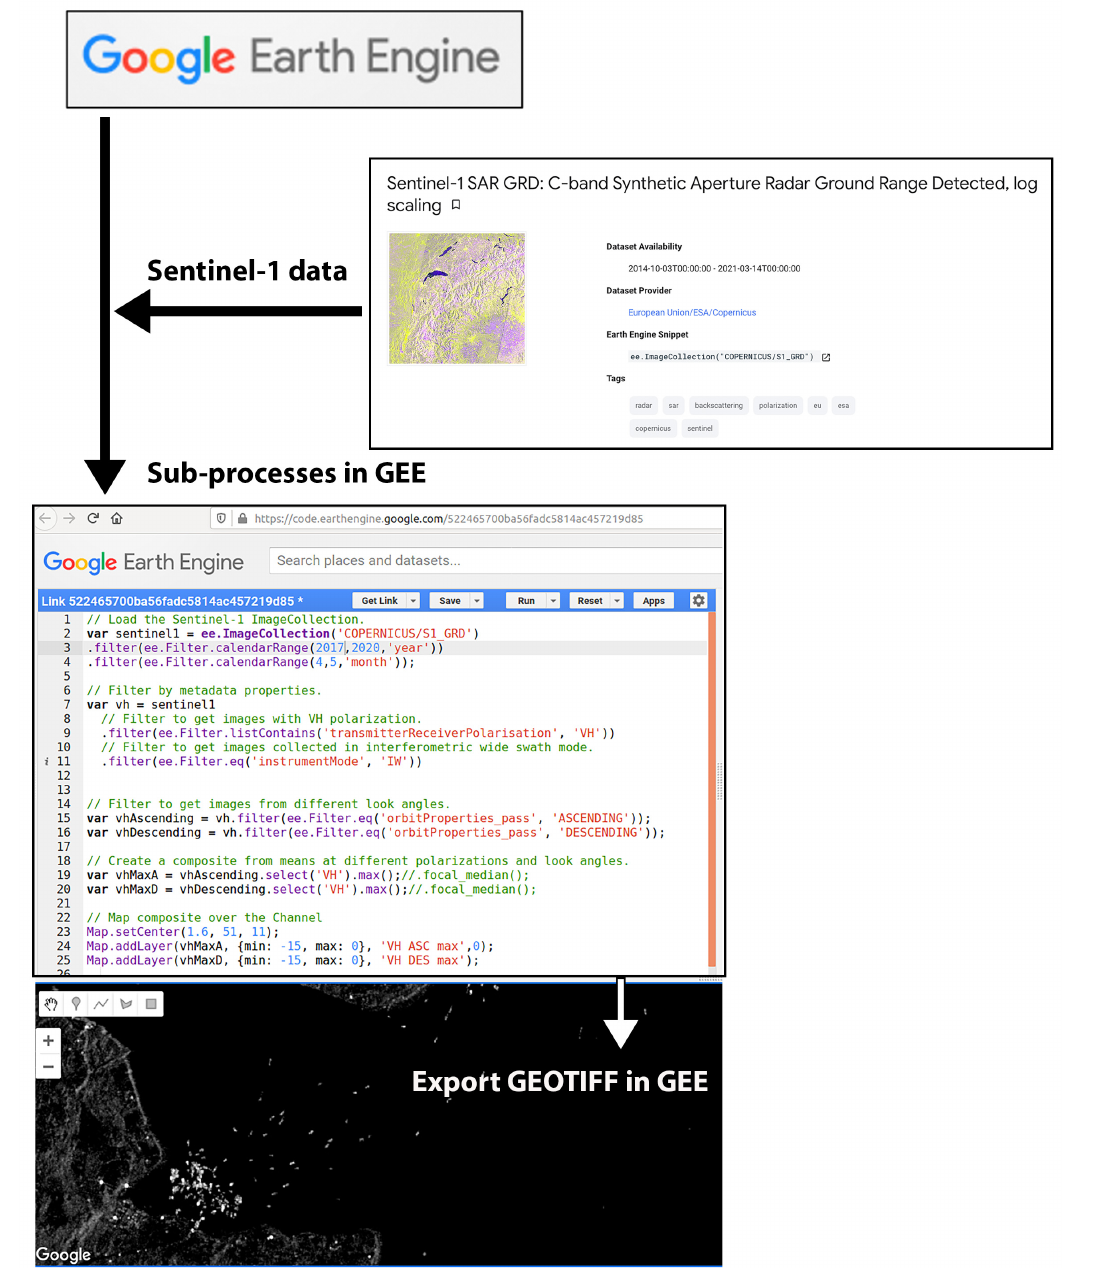
Figure 2. Flowchart of the methodological analysis used to geographically define the areas of study and to quantify the vessels in